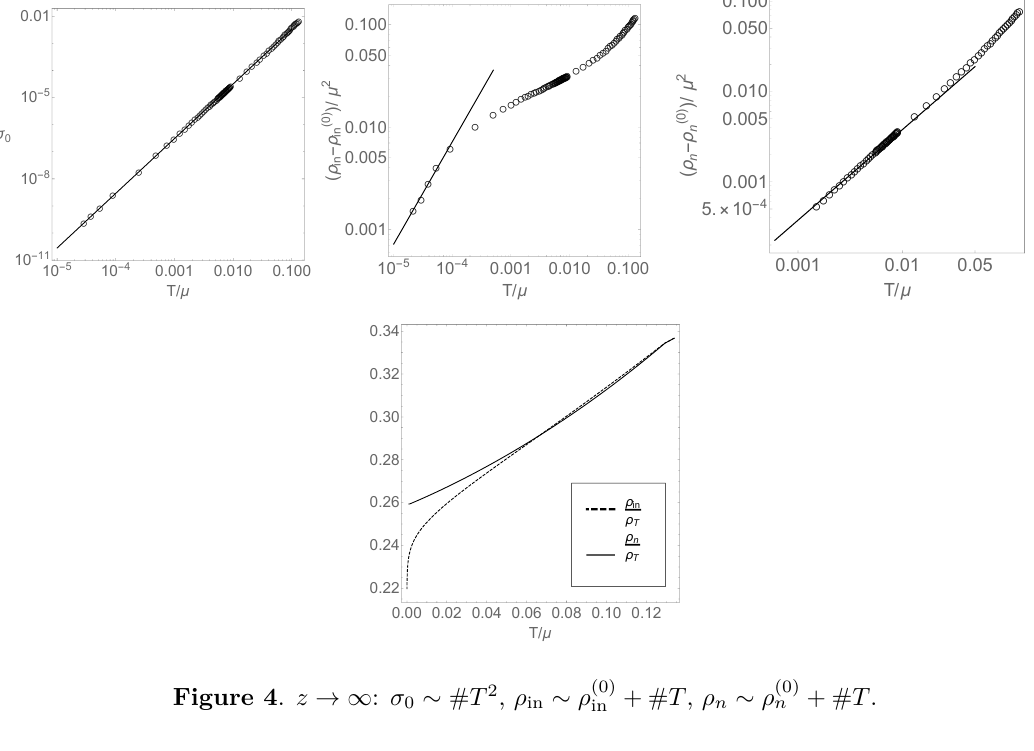
+ # T , ρ n ∼ ρ (0) n + # T in